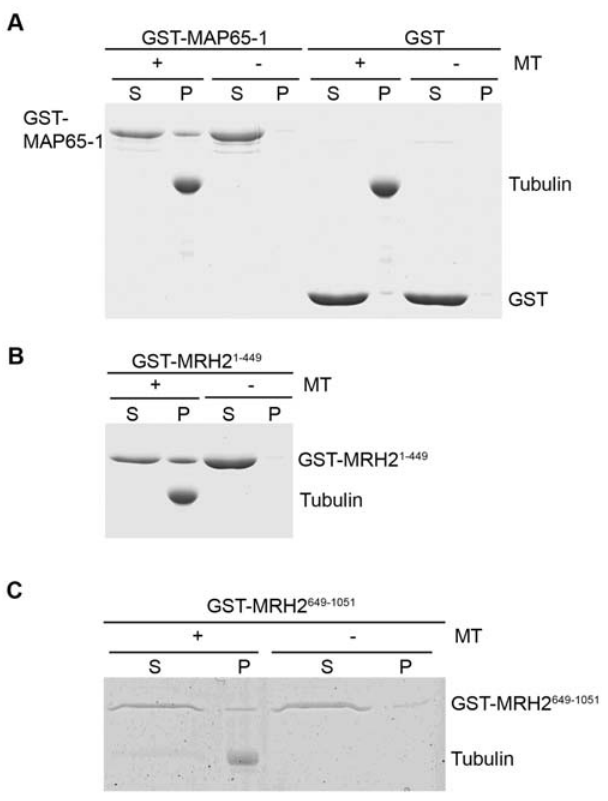
Figure 9. Co-sedimentation of MRH2 1-449 and MRH2 649-1051 with the polymerized tubulin. Equal amounts of proteins were loaded in the presence ( + ) or the absence ( 2 ) of the polymerized tubulin (MT). After high-speed centrifugation, proteins from the supernatant (S) and the pellet (P) were separated on the SDS-PAGE gel. (A) Control experiments for the co-sedimentation assay. GST-MAP65-1 (5 m M, positive control) or GST (10 m M, negative control) were loaded to 5 m M MT. (B) GST-MRH2 1-449 (10 m M) was loaded in the presence or absence of 5 m M MT. (C) GST-MRH2 649-1051 (1 m M) was loaded in the presence ( + ) or the absence ( 2 ) of 2 m M